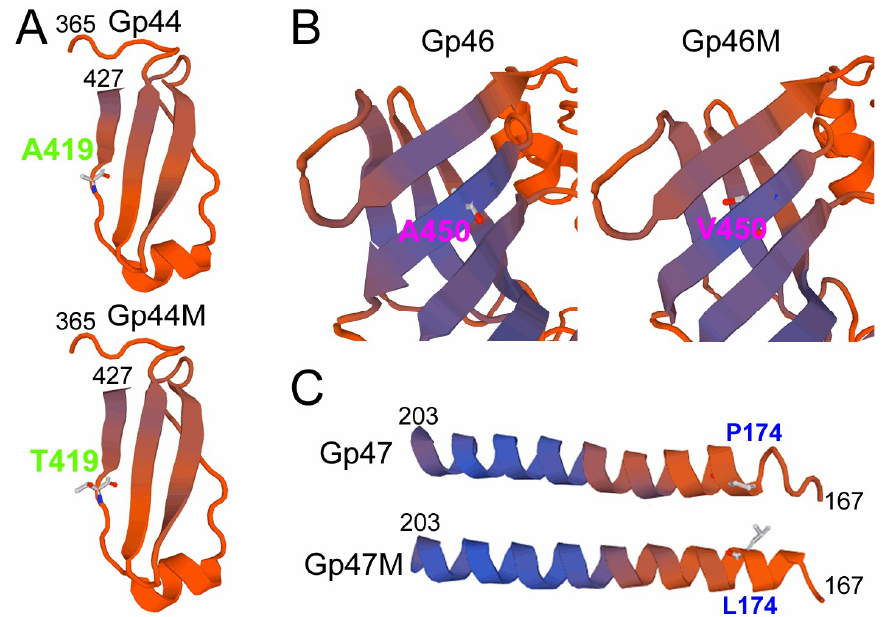
Figure 6. Predicted structure of the regions in the mutant proteins from the phage genome. Structural modelling of the baseplate protein Gp44 ( A ), tail endopeptidase protein Gp46 ( B ) and distal tail protein Gp47 ( C ). The structures of the peptides containing the mutant sites are shown. The positions of the mutant amino acid residues and the positions of the shown peptides in the proteins are indicated.